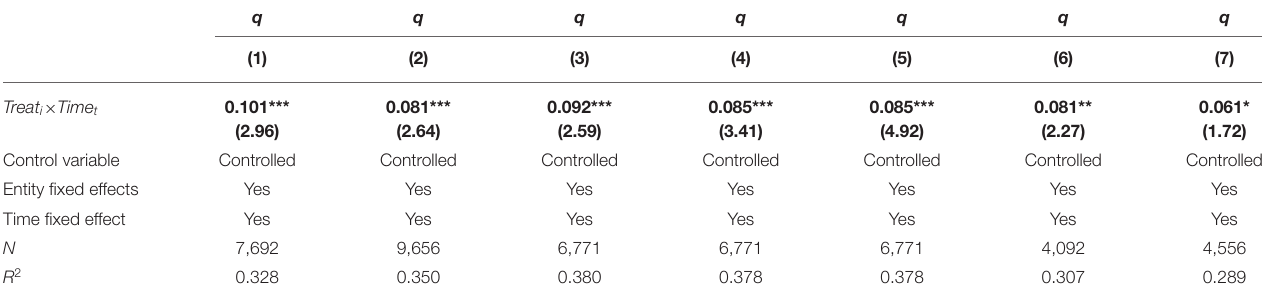
TABLE 3 | Robustness test.